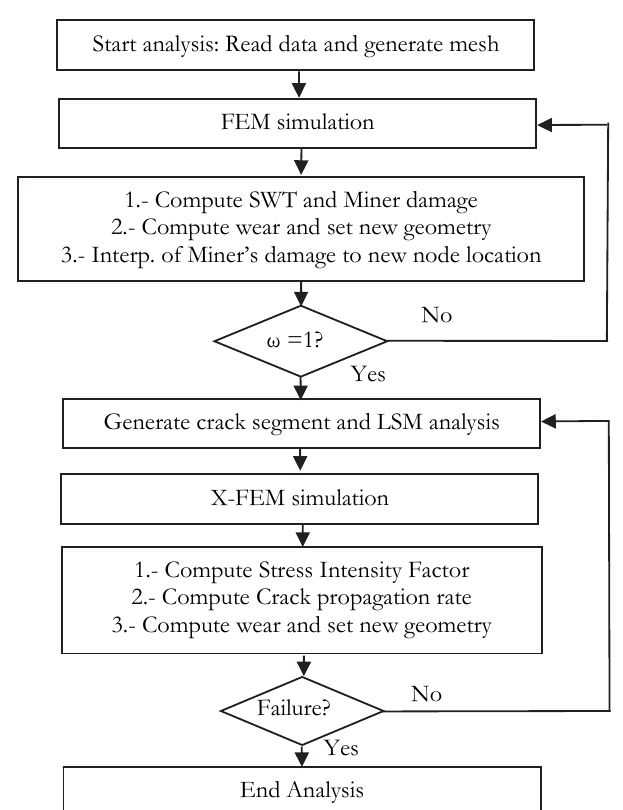
Figure 3: Flow chart showing computational sequence for numerical